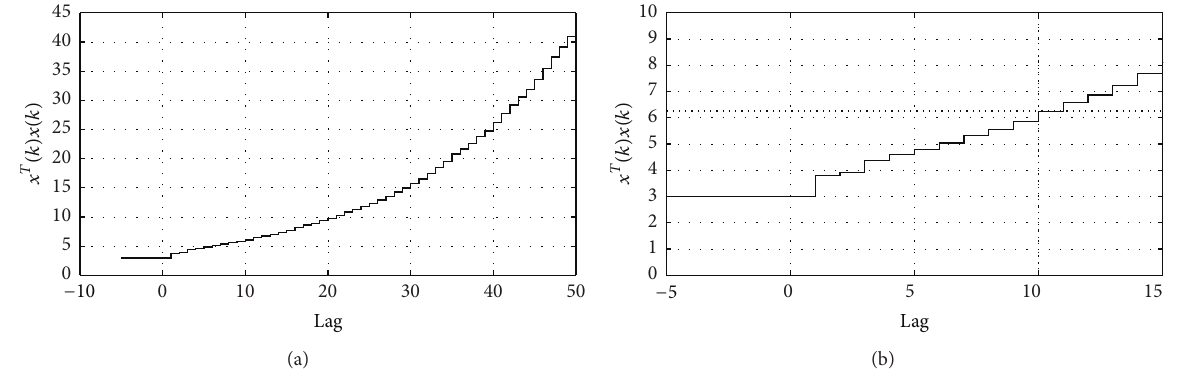
Figure 3: The norm of initial state responses of system (56) for (a) −10 ≤ 𝑘 ≤ 50 and (b) −5 ≤ 𝑘 ≤ 15 .